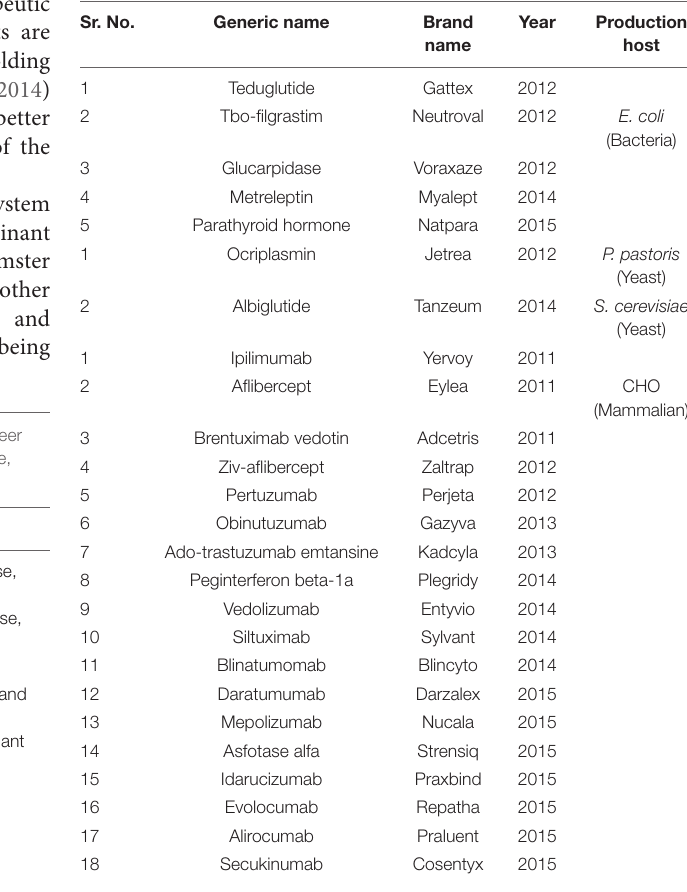
TABLE 2 | Novel recombinant proteins produced by different expression systems, 2011–2015 [Wells and Robinson, 2016 and New Drugs at FDA: CDER’s New Molecular Entities and New Therapeutic Biological Products (http://www.fda.gov/Drugs/DevelopmentApprovalProcess/DrugInnovation/),